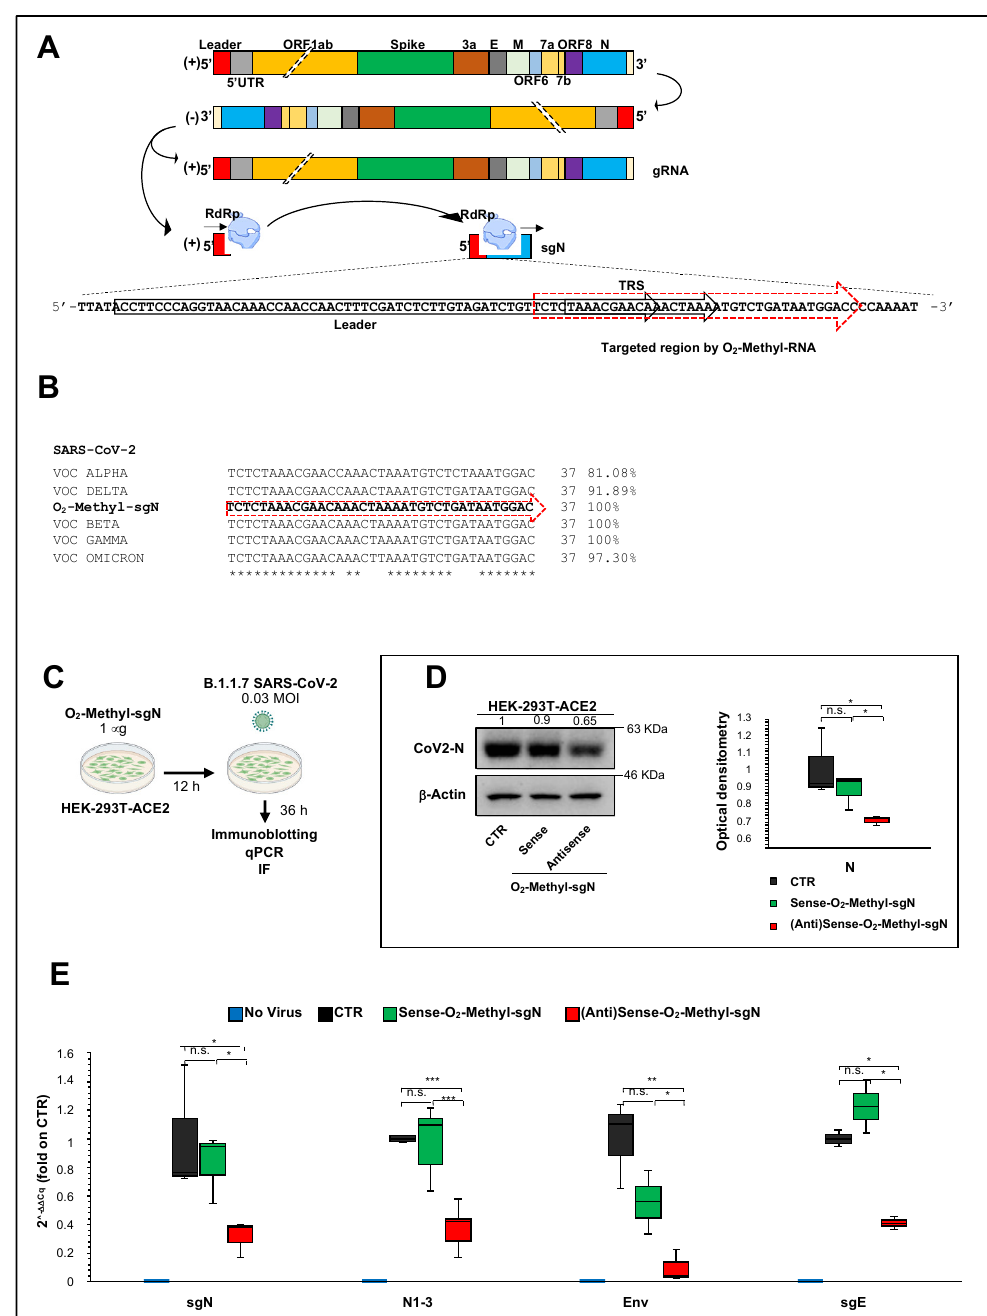
Figure 3. Reduction of viral load by targeting sgN in HEK293T ‐ ACE2 SARS ‐ CoV ‐ 2 ‐ infected cells: ( A ) Schematic representation of the SARS ‐ CoV ‐ 2 genome organization, the canonical sgRNAs bio ‐ genesis (according to the “leader ‐ to ‐ body fusion” model) and the 2’ ‐ O ‐ methyl antisense RNA de ‐ sign. During its viral cycle, SARS ‐ CoV ‐ 2 virus replicates its positive sense (+) genomic RNA (29,903 nt) to produce full ‐ length negative ‐ sense ( − ) RNA molecules that act as templates for the synthesis of new positive ‐ sense (+) gRNAs, which are then packaged into newly assembled virions. However, according to the “leader ‐ to ‐ body fusion” model [1], during negative ‐ strand synthesis, the replica ‐ tion complex (including RdRp) interrupts the transcription when it crosses a transcription ‐ regula ‐ tory sequence (TRS) located upstream to most ORFs (including gene N) in the 3 ′ one ‐ third of the viral genome (TRS ‘body’, or TRS ‐ B). Thus, the synthesis of the negative ‐ strand ( − ) RNA is re ‐ initi ‐ ated at the TRS in the leader sequence (TRS ‐ L, red box) at 70 nucleotides from the 5 ′ end of the genome. Through this mechanism, a negative strand copy of the leader sequence is added to the nascent RNA to complete the synthesis of negative ‐ strand ( − ) sgRNAs. These negative RNAs are then used as templates to synthesize positive ‐ sense (+) sgRNAs that are translated into both